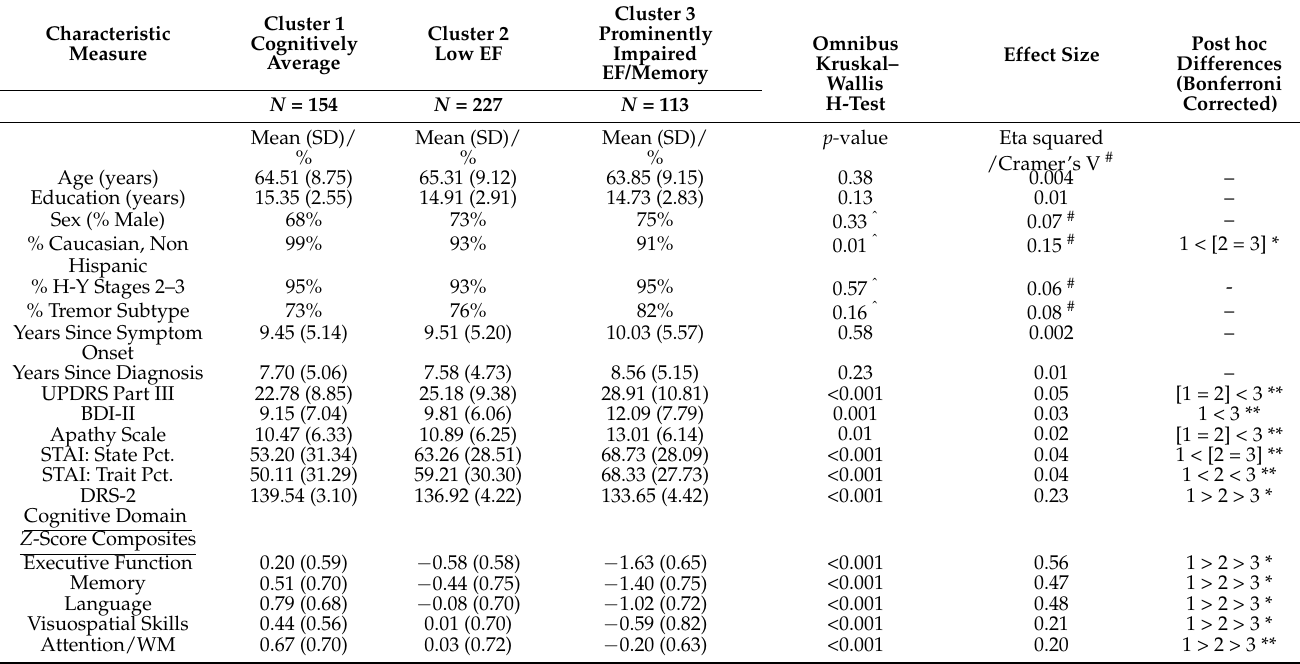
Table 3. Comparing the K-means Clusters’ Descriptive, Clinical, and Cognitive Characteristics.